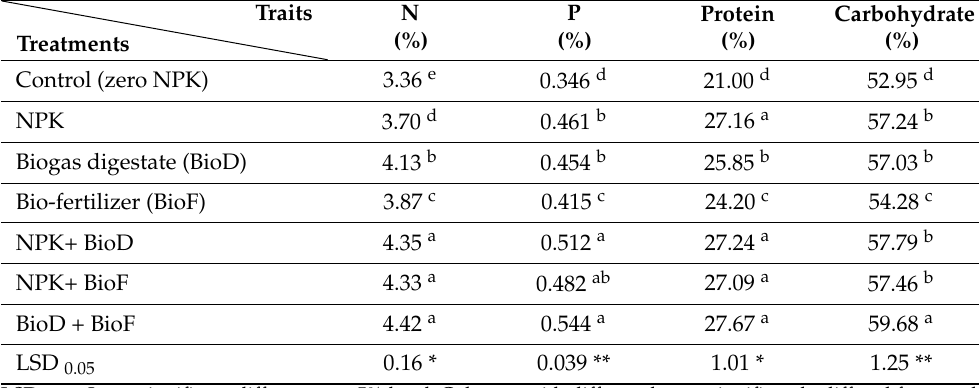
Table 3. Effect of synthetic, organic, and bio-fertilizers on the percentage of N, P, protein, and carbohydrates of faba bean